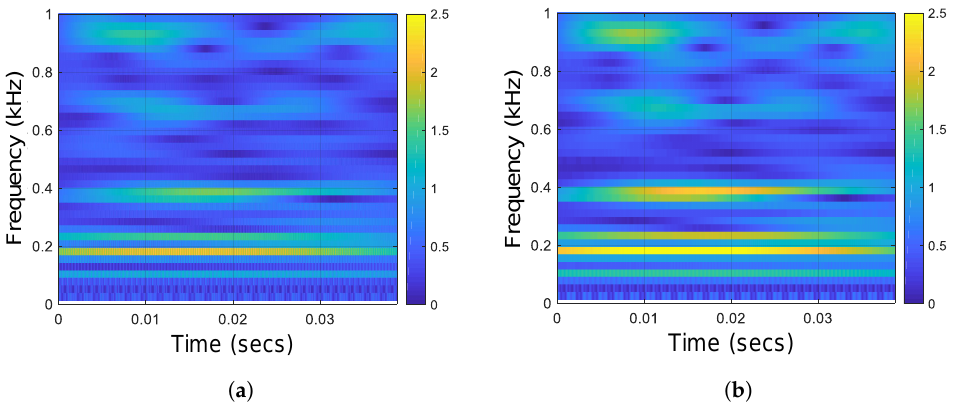
Figure 11. ( a ) Spectrogram of the original signal. ( b ) Spectrogram of the high-resonance component.